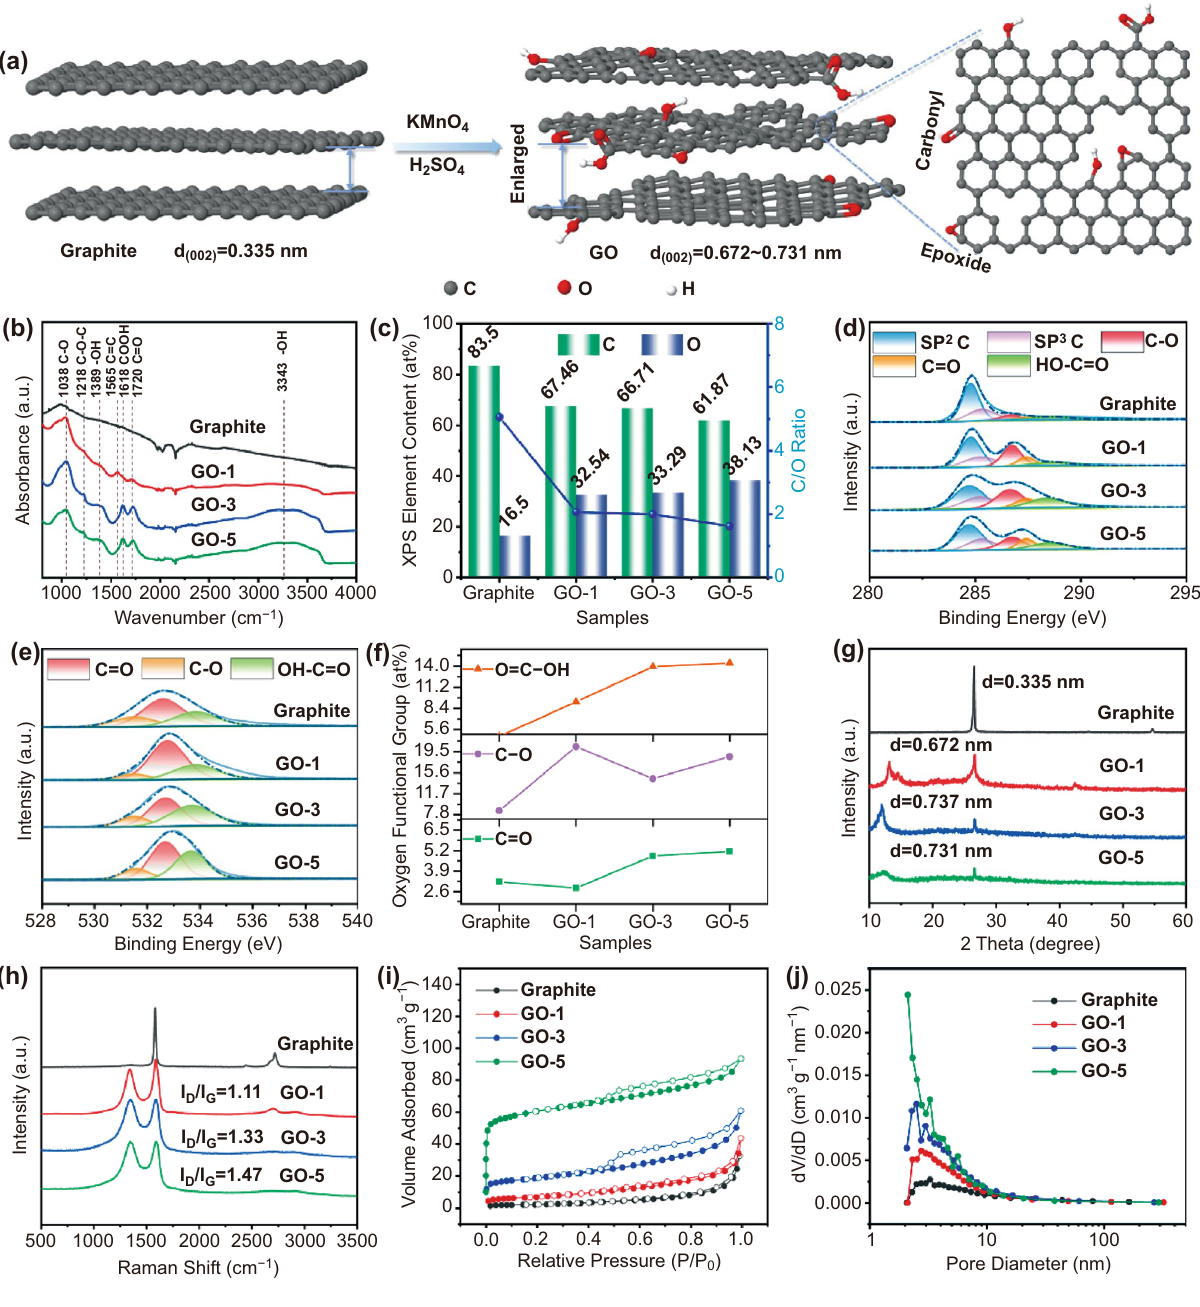
Fig. 1 Schematic illustration of the synthesis and material characterization of graphite and GO samples. a Schematic illustration of the synthe- sis of GO. b FT-IR spectra. c XPS elements contents. d High-resolution C 1s spectra. e High-resolution O 1s spectra. f O element types content. g XRD patterns. h Raman spectra. i Nitrogen adsorption–desorption isotherms. j Pore size